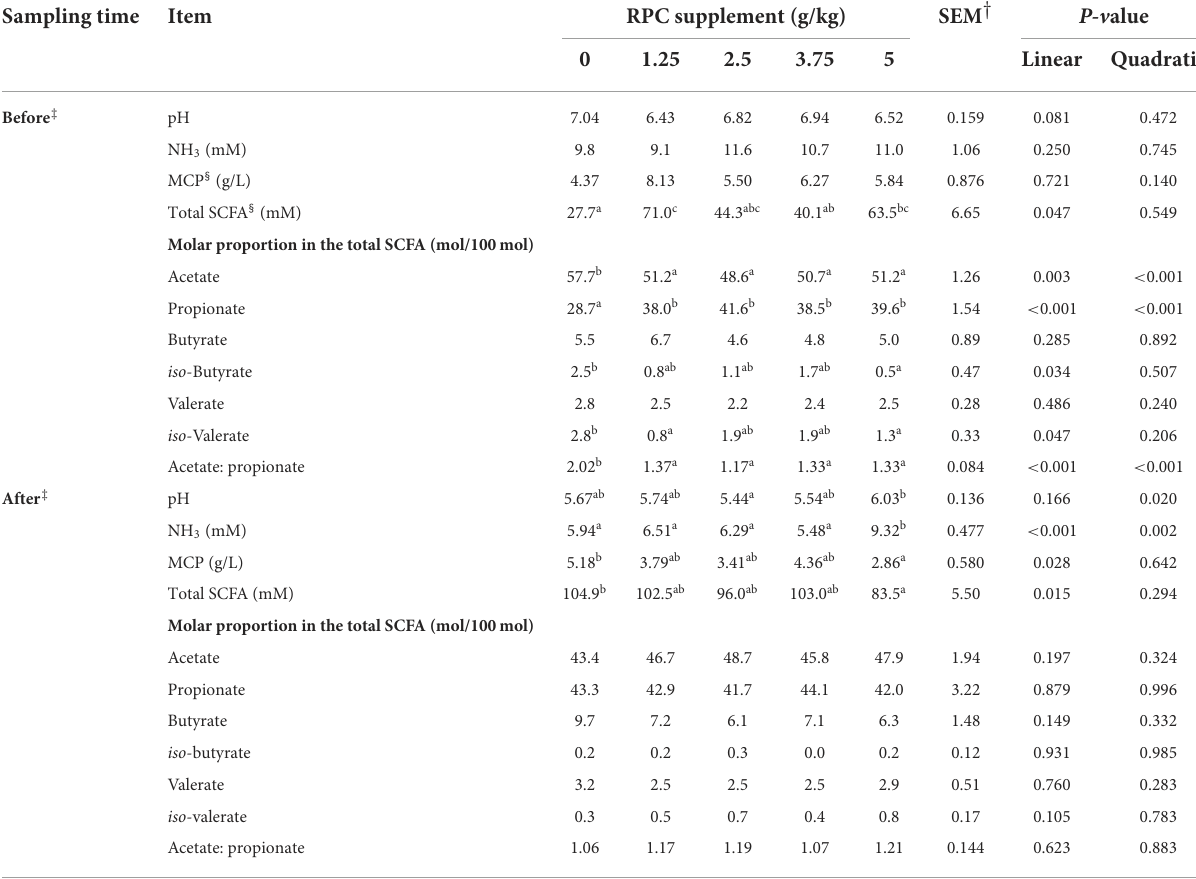
TABLE 4 Rumen fermentation parameters of fattening lambs fed experimental diets supplemented with nil (CON) or rumen-protected choline (RPC) ( n = 6 per treatment). Sampling